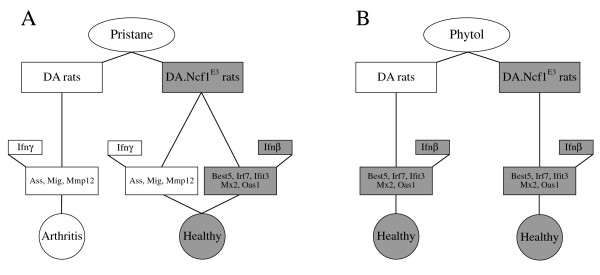
Schematic representation of the differentially expressed genes and how they are induced upon injection by (A) pristane or (B) phytol. The molecular pathway that is shared between the arthritis resistant DA.Ncf1E3 rat strain and the arthritis treatment achieved with phytol is the Ifn-β-dependent pathway, which results in the upregulation of Best5, Irf7, Ifit3, Oas1 and Mx2. The inflammatory arthritis that is induced by an injection with pristane is characterized by increased expression of the Ifnγ-connected signature genes Ass, Cxcl9 and Mmp12, which potentially could be used as molecular markers for an initiating inflammatory response. As this pathway is also induced by pristane in the DA.Ncf1E3 strain this upregulation per se does not cause arthritis. Most important in this mechanism is how administration of phytol induces arthritis protection via the Ifn-β-regulated pathway in the arthritis-susceptible DA rats.